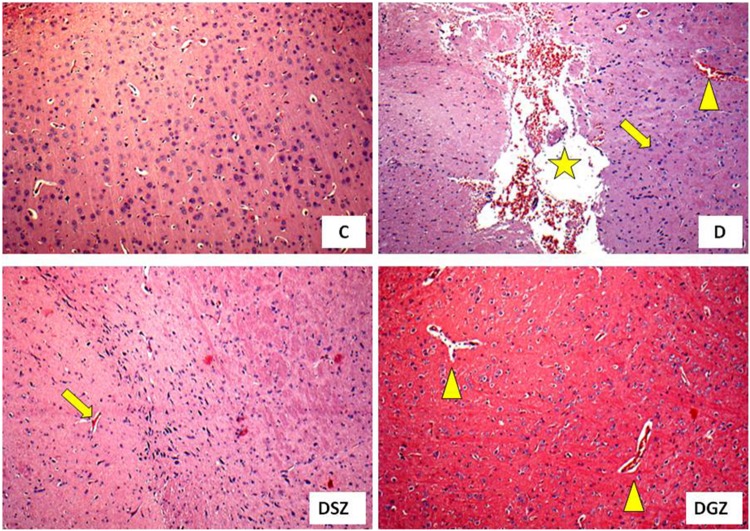
Histology of the cerebral cortex of diabetic rats treated with two different zinc compounds (H and E, × 100) C, control group (n = 8); D, diabetic group (n = 10), the arrow indicates ischemic neurons, the star indicates hemorrhage and the triangle indicates dilated vessels; DSZ, diabetic group supplemented with Zn Sulpfate (n = 10), the arrow indicates ischemic neurons; DGZ: Diabetic Group Supplemented with Zn Gluconate (n = 10), the triangle indicates dilated vessels.